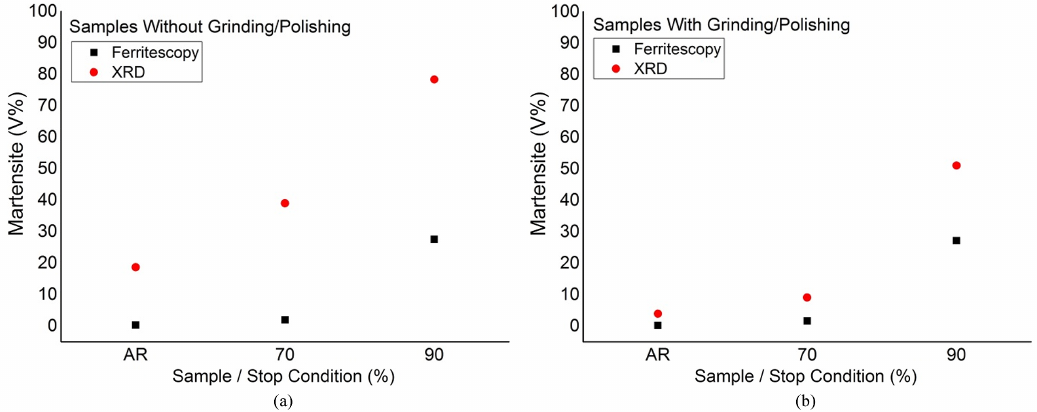
Figure 4. Volume fraction of martensite by ferritoscopia and diffraction X-ray in samples without and with metallographic preparation. Plastic strain ratio 1.00×10 –2 s –1 .